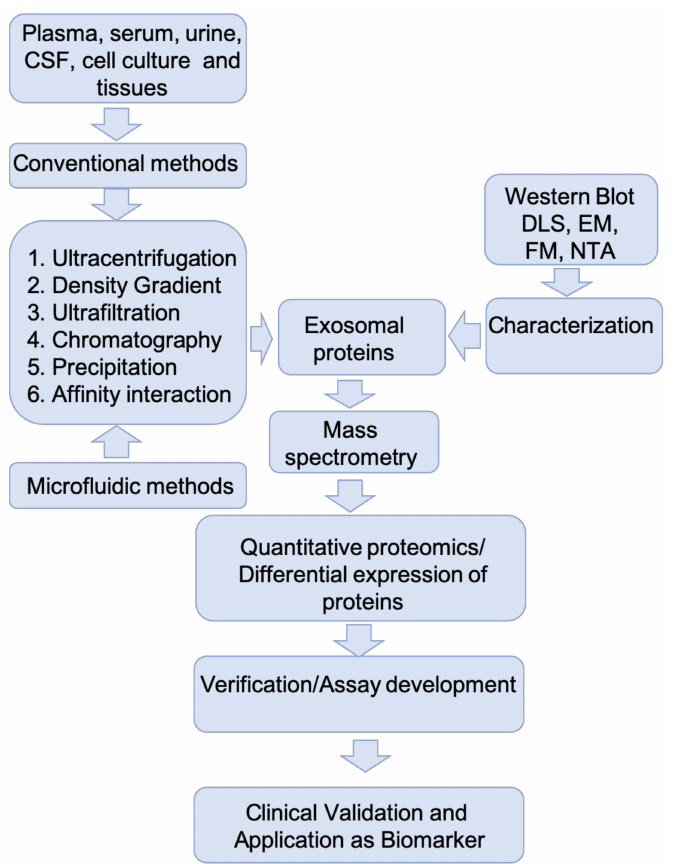
Figure 2. MS pipeline for identification and validation of protein biomarkers in exosomes for neurological disorders: nanoparticle tracking analysis (NTA), fluorescence microscopy (FM), electron microscopy (EM), dynamic light scattering